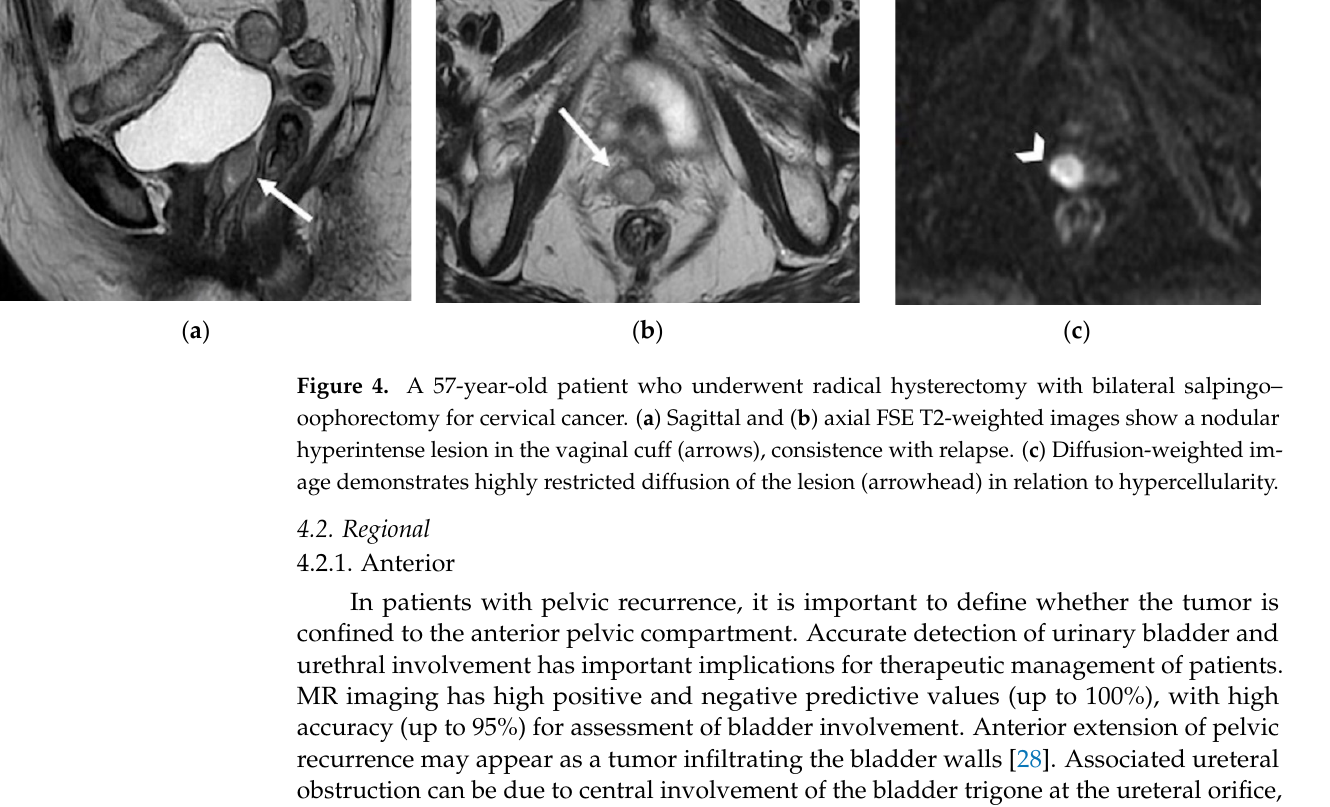
Figure 3. A 32-year-old woman who underwent previous chemoradiation therapy for cervical can- cer. ( a ) Coronal and ( b ) axial FSE T2-weighted images show a soft-tissue mass in the right para- metrium (black arrows). Note the contact with the right ureter embedded by the lesion (arrowhead). ( c ) Diffusion-weighted image shows focus of hyperintense signal into the lesion (white arrow). The finding was confirmed to be recurrence at surgery.